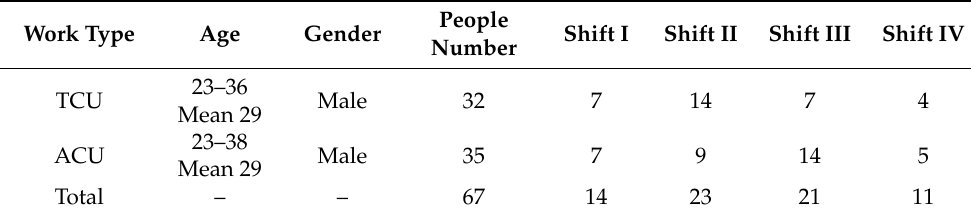
Table 4. General information of the ATCO